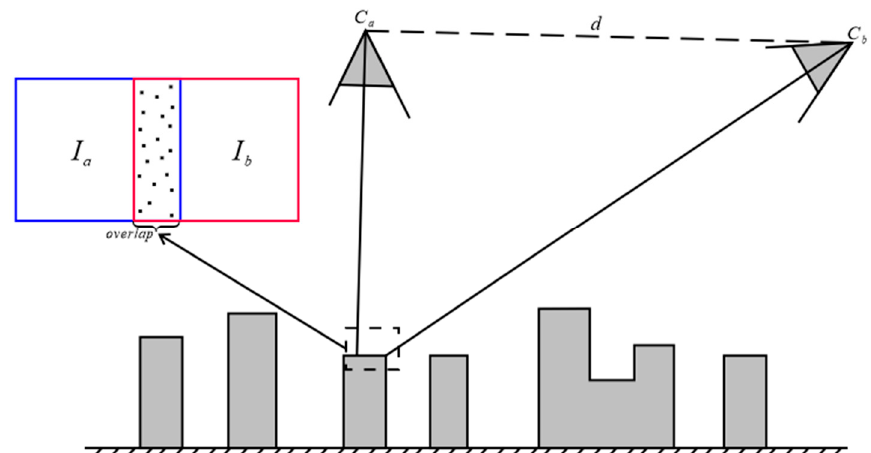
Figure 1. Camera station and image pair diagram.